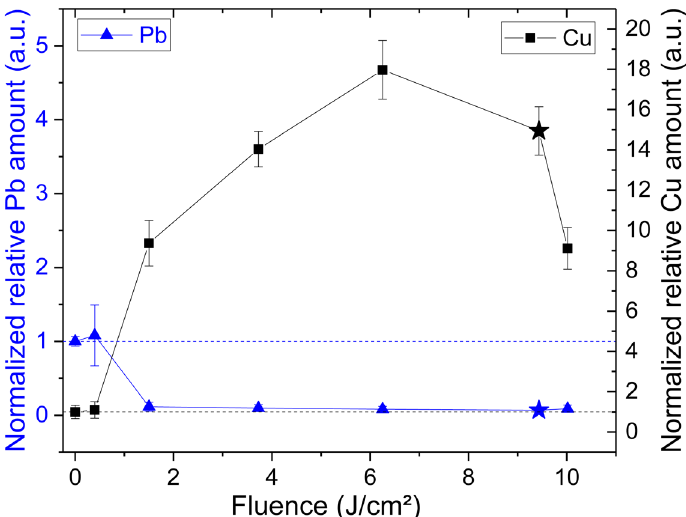
Fig. 9. EDX investigation of the material composition in the P2 scribe lines as a function of the applied laser fl uence. The blue triangles correspond to elemental Pb (M line) used as indicator for the perovskite absorber (left y -axis). The black squares refer to elemental Cu (L line), which corresponds to the underlying CIGSe absorber (right y -axis). The selected fl uence is marked with an